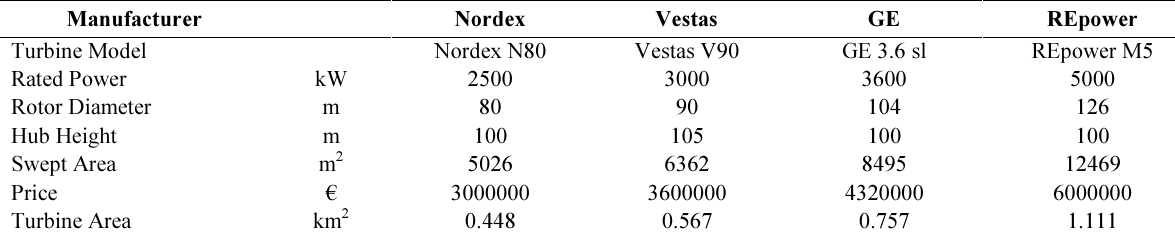
Table 1. The main parameters of wind power plants